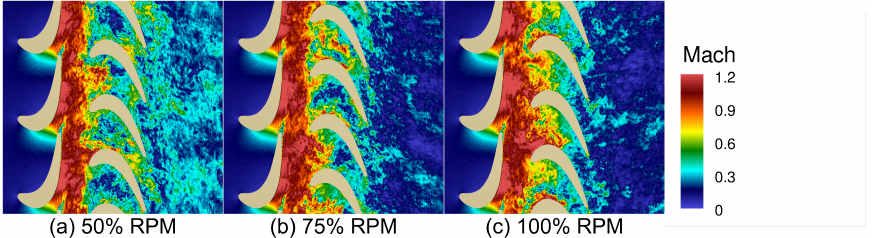
Figure 18. Instantaneous Mach number contours near the stator–rotor region at 50% span location of the rotor blade for: ( a ) 50% RPM; ( b ) 75% RPM; and ( c ) 100% RPM.